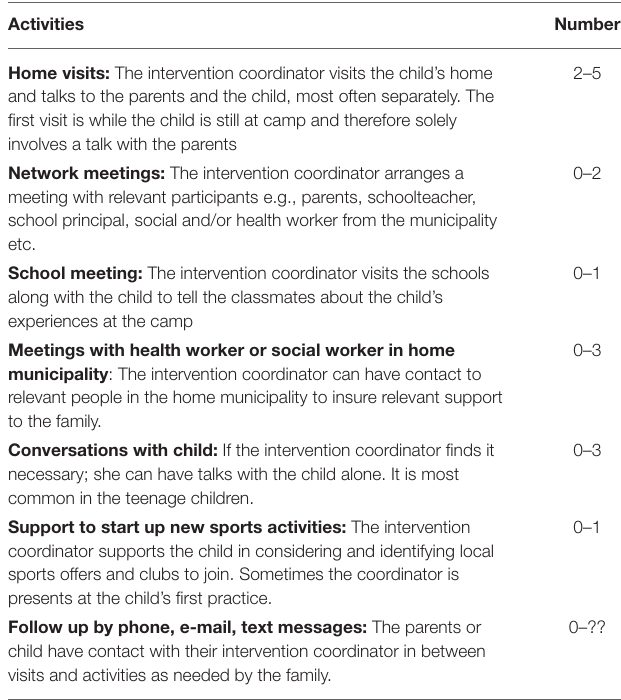
TABLE 2 | Activities in the extended maintenance intervention and